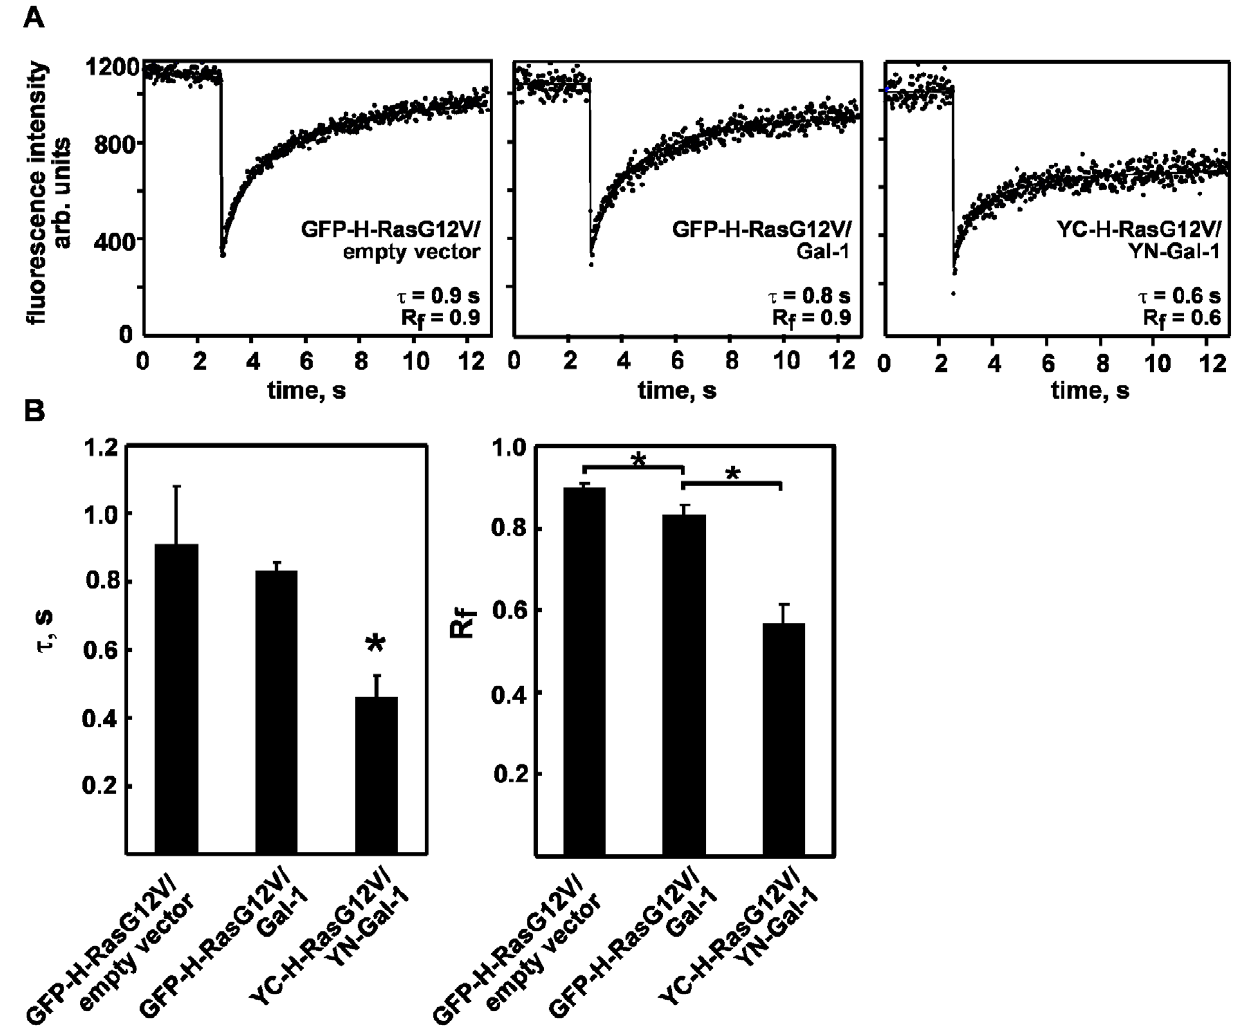
Figure 1. GFP-H-RasG12V and Gal-1 form mobile and immobile complexes on the plasma membrane. BHK cells transiently co- expressing GFP-H-RasG12V/empty control, GFP-H-RasG12V/Gal-1, GFP-H-Ras/empty vector, GFP-H-Ras/Gal-1, YC-H-RasG12V/YN-Gal-1 or YC-H-Ras/ YN-Gal-1 were analyzed by FRAP. A. Typical FRAP curves recorded with a 40 6 objective in the indicated co-transfectants are shown. The half time of fluorescence recovery ( m ) and mobile fraction (Rf) of these typical curves are indicated. B. Statistical analysis of m and Rf recorded with 40 6 objective in each of the cotransfectants. Bars represent the mean values ( 6 SEM, n=15–60). * P , 0.001.